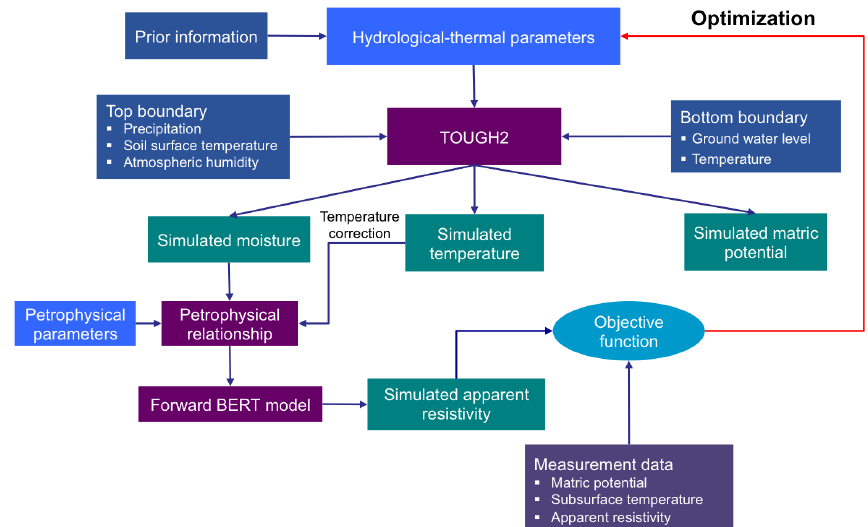
Figure 1. Flowchart showing the steps involved in the coupled hydrological-thermal-geophysical inversion scheme. The objective function is represented by Eq. (15). Estimated parameters consist of hydrological-thermal and petrophysical parameters (blue rectangles). The navy blue rectangles denote the model inputs, including prior information about estimated parameters, and the top and bottom boundary conditions. The purple rectangles denote the forward TOUGH2, geophysical and petrophysical models. The teal and indigo rectangles, respectively, denote the simulation and measurement. Data for inversion in this study include matric potential, subsurface temperature and apparent